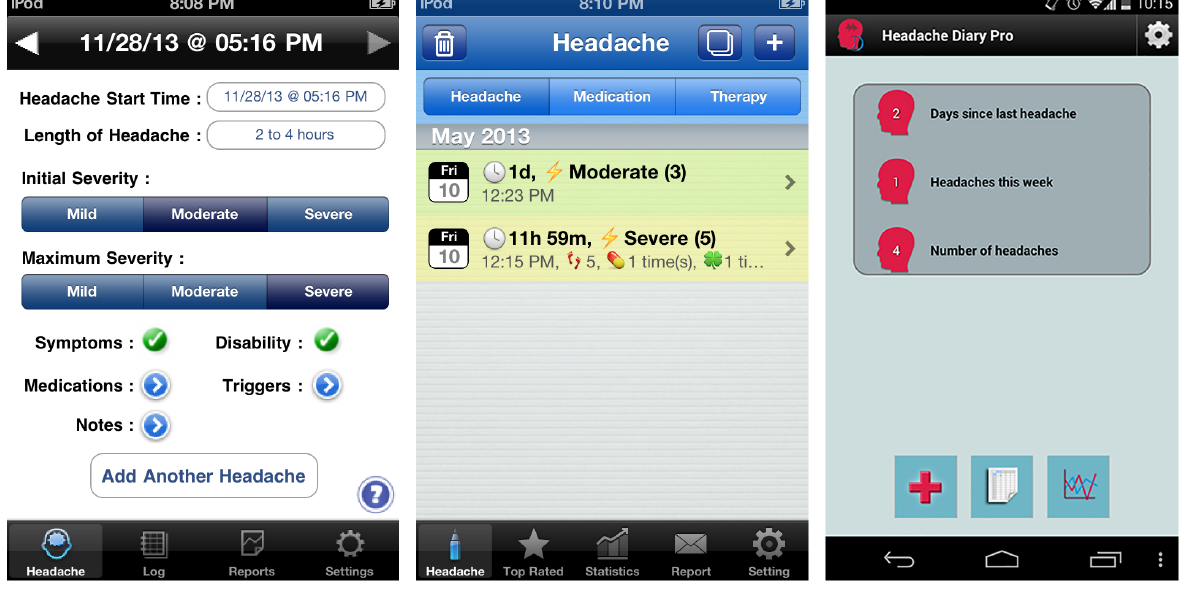
Number of apps meeting the criterion,